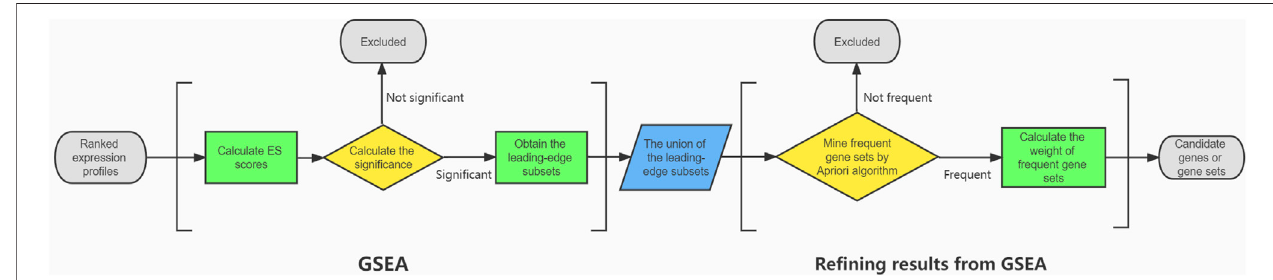
FIGURE 6 | The fl owchart of the proposed